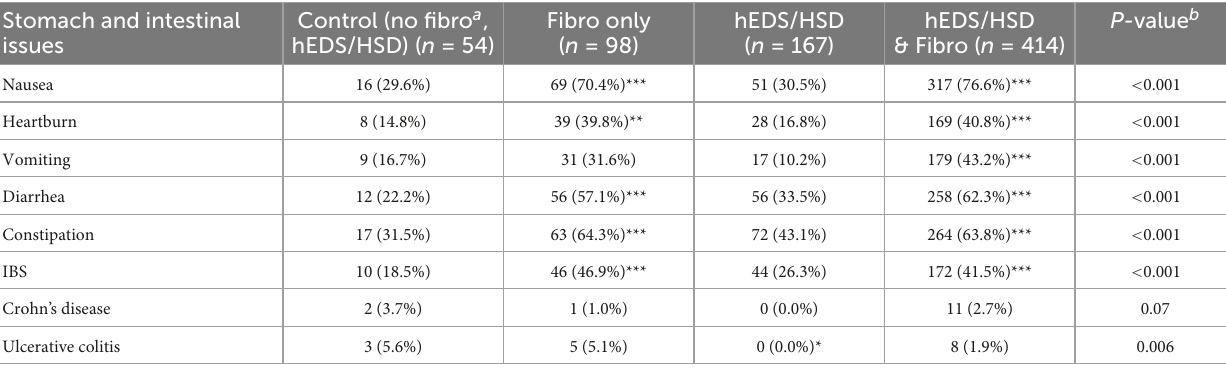
TABLE 5 Stomach and intestinal issues in female and male patients diagnosed with fibromyalgia, hypermobility (hEDS or HSD) or hEDS/HSD and fibromyalgia compared to controls ( n = 733). Stomach and intestinal